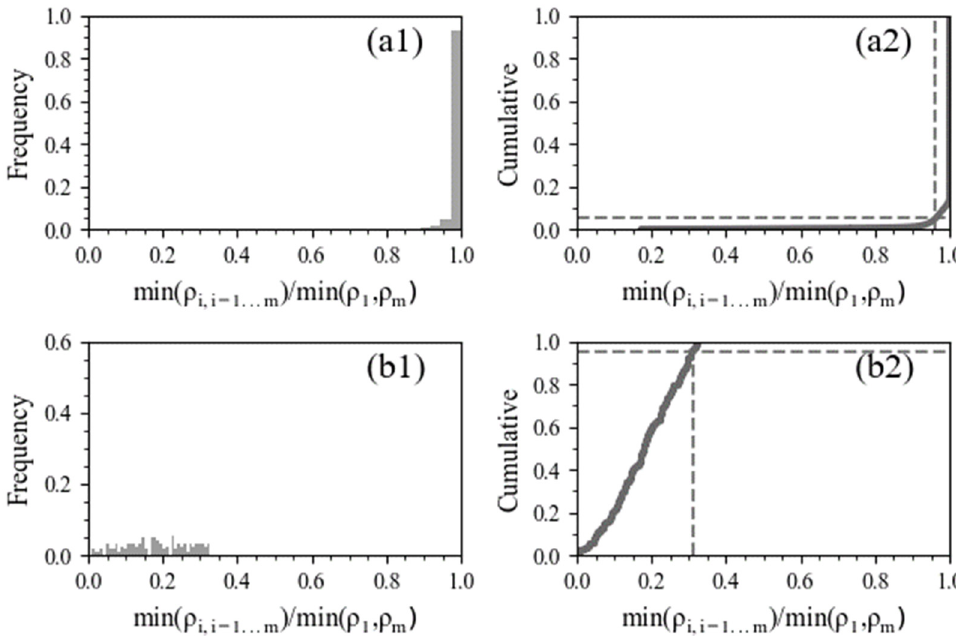
(cid:0) (cid:1) ρ i , i = 1... m /min ( ρ 1 , ρ m )) , is defined to